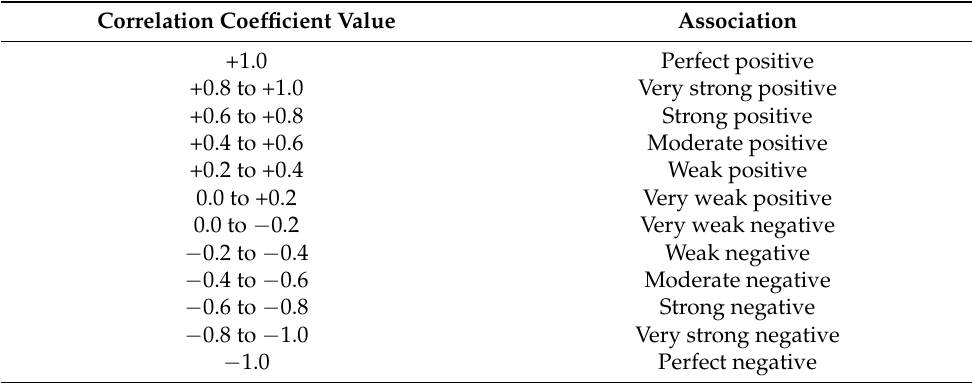
Table 3. Correlation coefficients and their